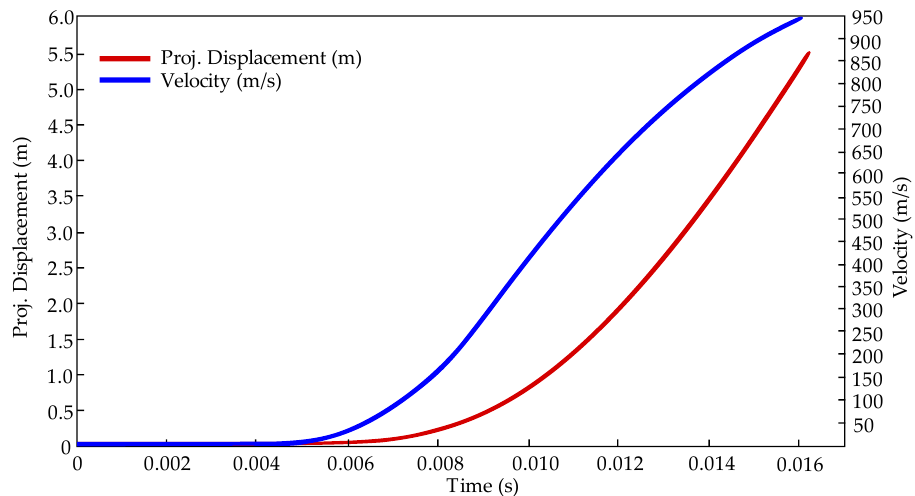
Figure 10. Three-dimensional numerical results for 155/52 six-module charge firing test. Gas volu- metric fraction 𝛼 1 at different times: ( a ) 𝑡 = 0; ( b ) 𝑡 = 1.5 ms; ( c ) 𝑡 = 1.75 ms.